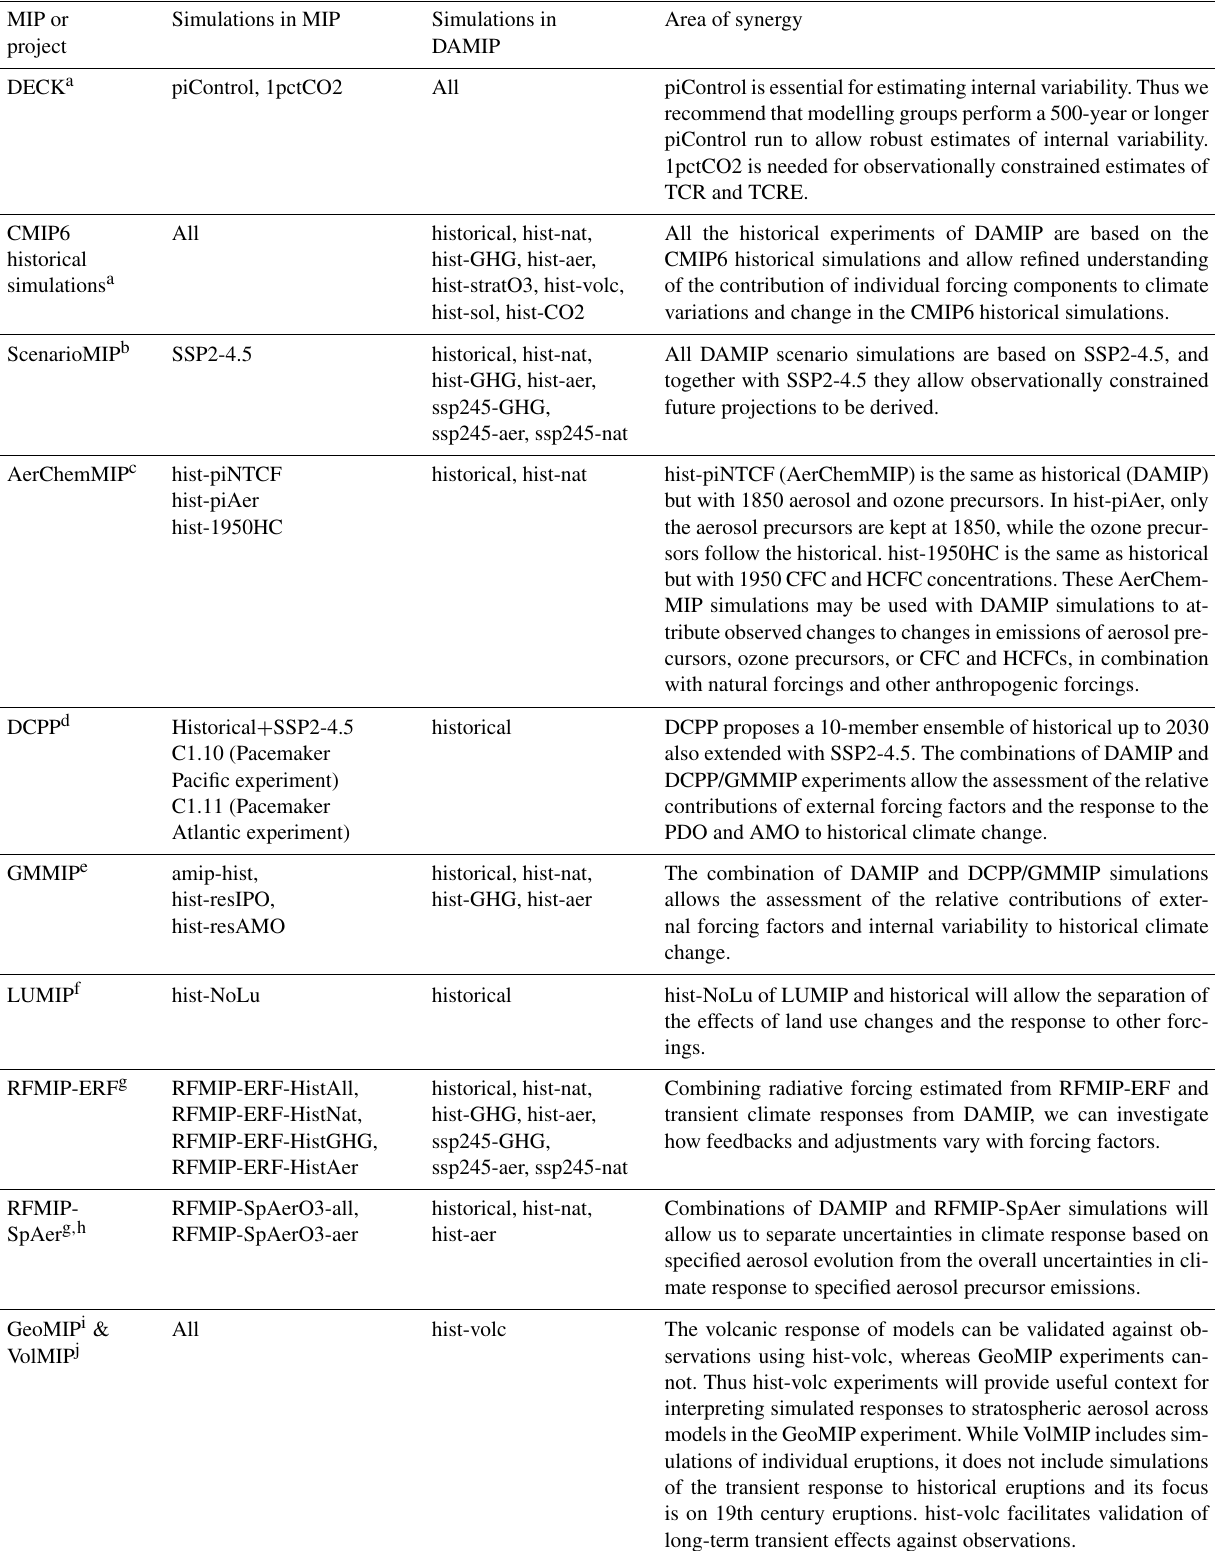
Table 2. Synergies with DECK, CMIP6 historical, and other